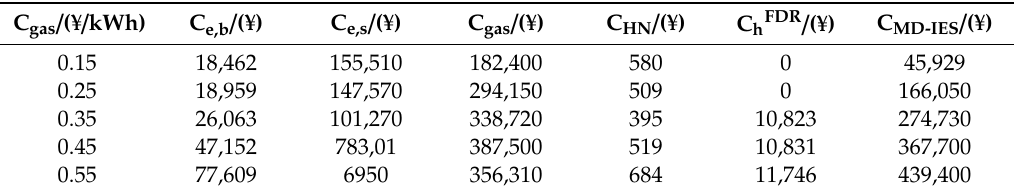
Table 7. Relation between the total operating cost and the price of natural gas with the heating network when c e,s = 0.7 ¥ / kWh.